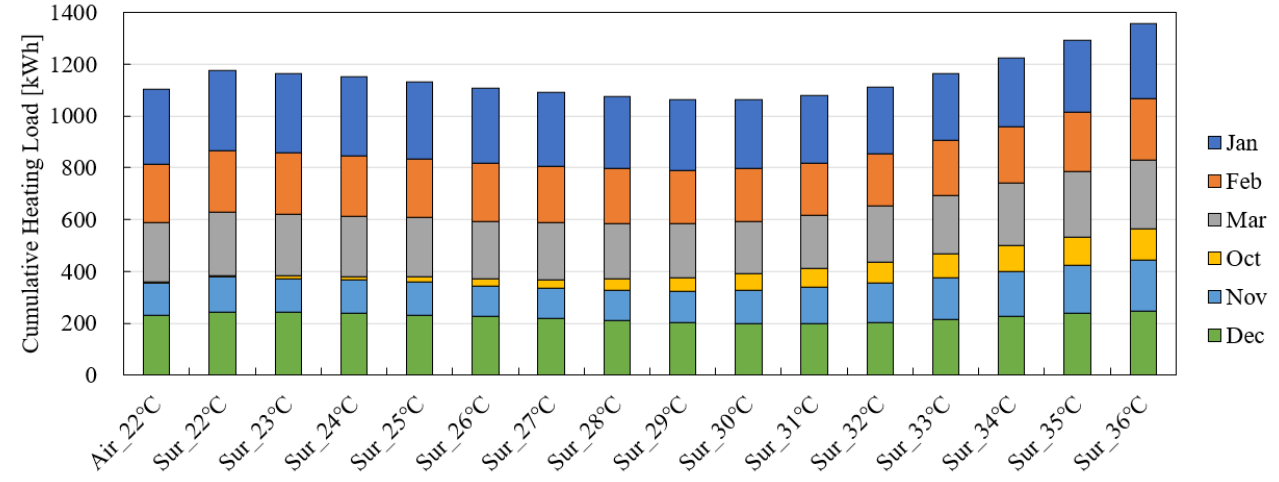
Figure 13. Variation in monthly heating load according to the control method and